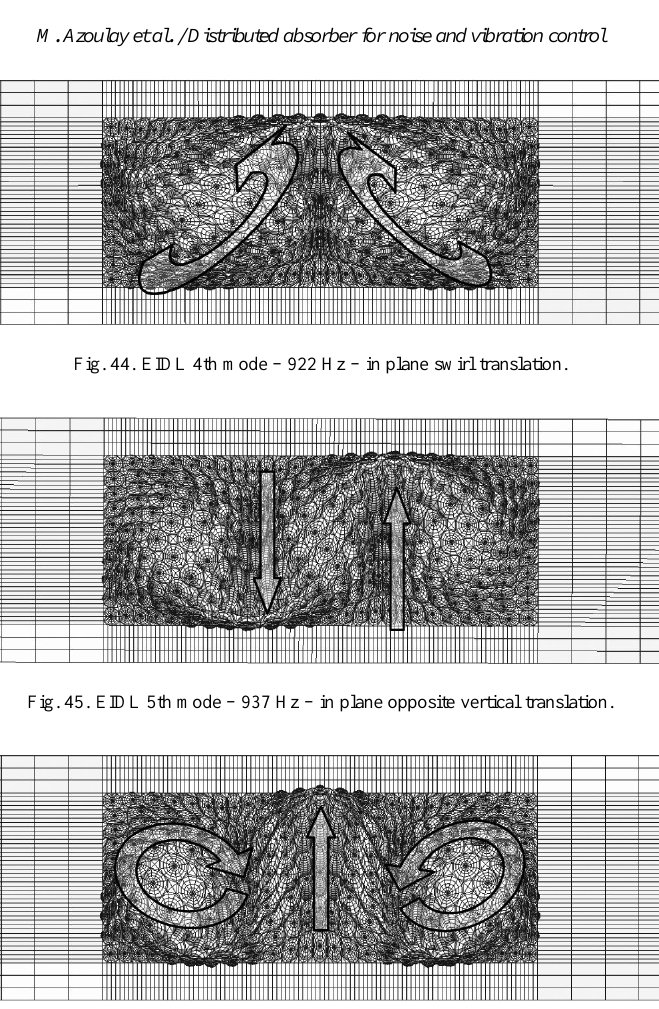
Fig. 46. EIDL 6th mode – 956 Hz – in plane swirl and horizontal translation combination.